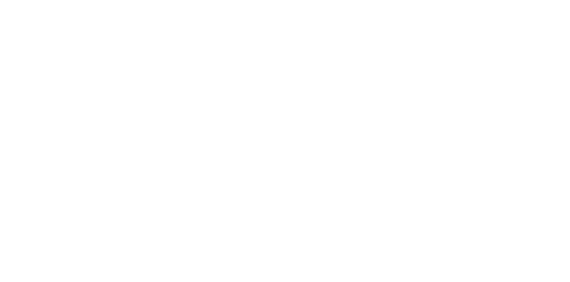
Table 4. Parameters of the analytical model in comparison analysis—Case II.